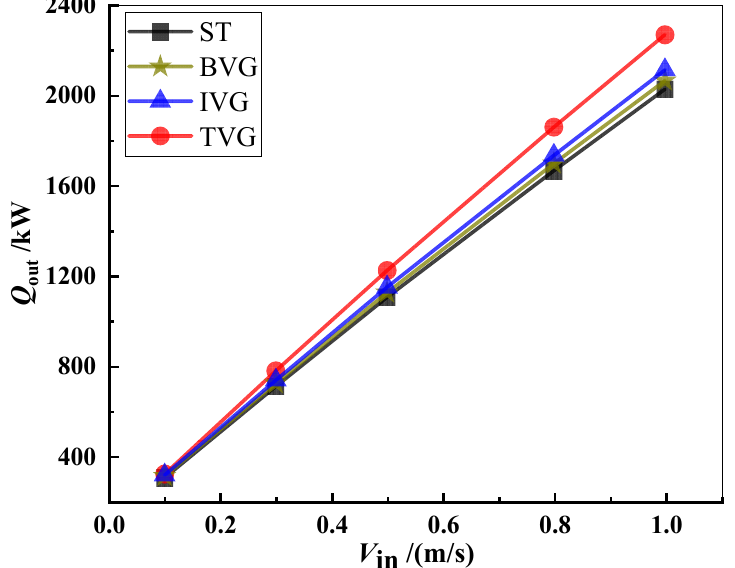
Figure 18. Variation curves of the heat recovery power of the four heat exchangers with inlet flow velocity.